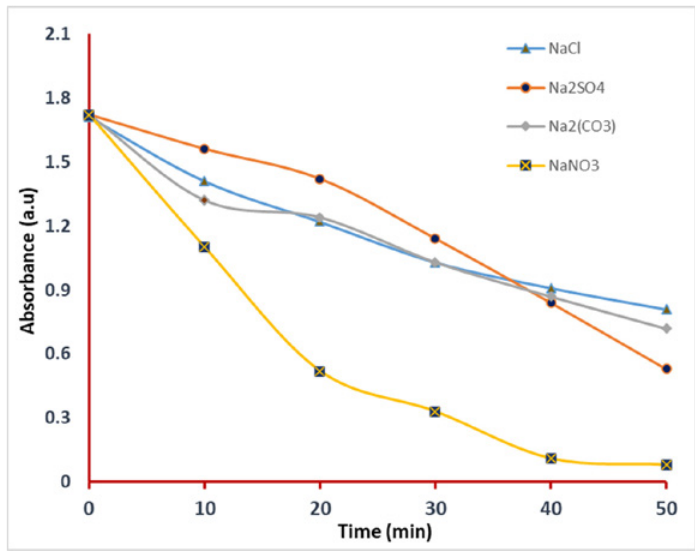
Fig. 13. Kinetic study on Nigrosin dye degradation using MgZrO